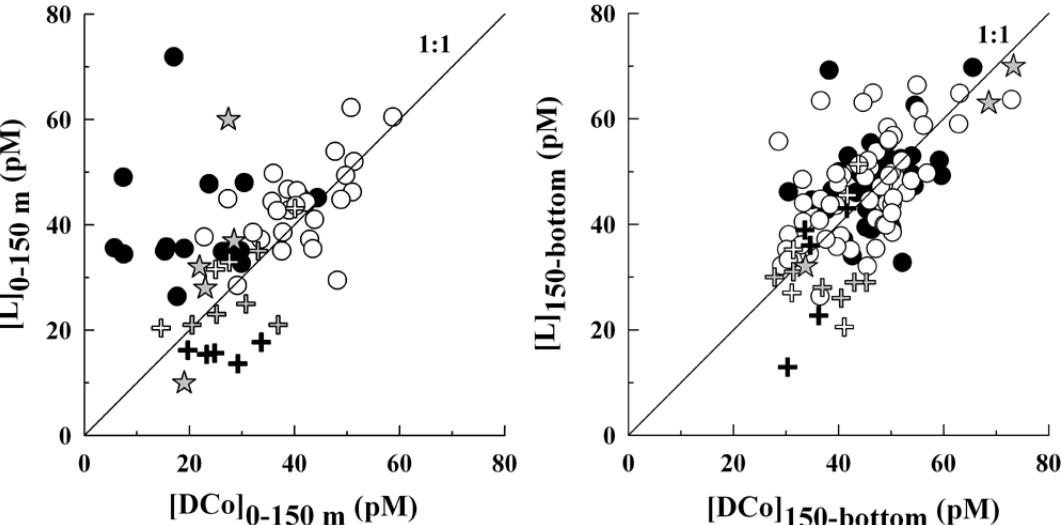
Fig. 7. Ocean data compilation of organic Co-binding ligands ( L) versus dissolved cobalt (DCo) concentrations in the top 150m ocean waters (right panel), and in the deep waters below 150m depth (left panel). Grey crosses: northeastern Atlantic (Ellwood and van den Berg, 2001); Black (north of PF) and white (south of PF) crosses: Southern Ocean (Ellwood et al., 2005); Grey stars: Sargasso Sea (Saito et al., 2001); Black circles: subtropical southeastern Atlantic and northern subantarctic domain (this study), White circles: Southern Ocean and northern Weddell Gyre (this study). The solid line represents the 1:1